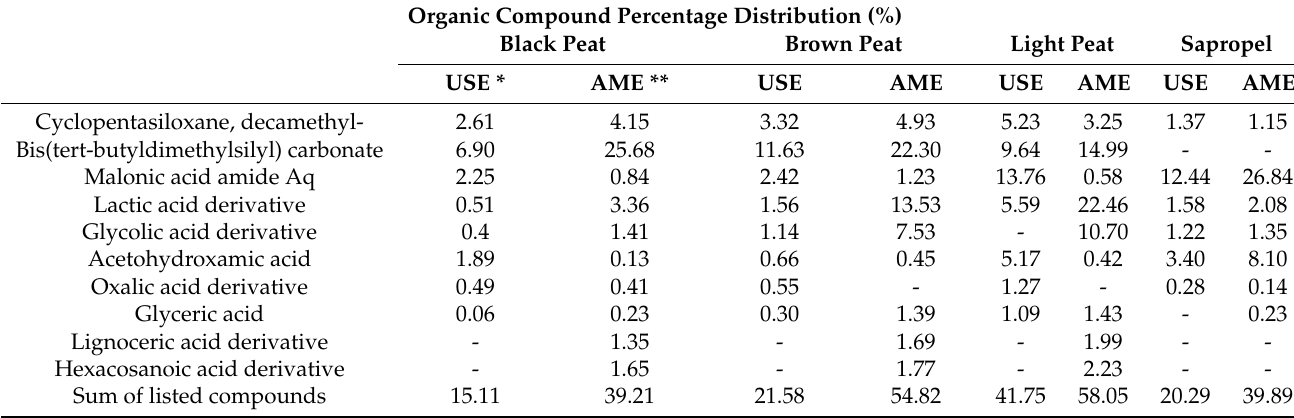
Table 1. Organic compound percentage distribution (%) in different peat and sapropel extracts. Organic Compound Percentage Distribution (%) Black